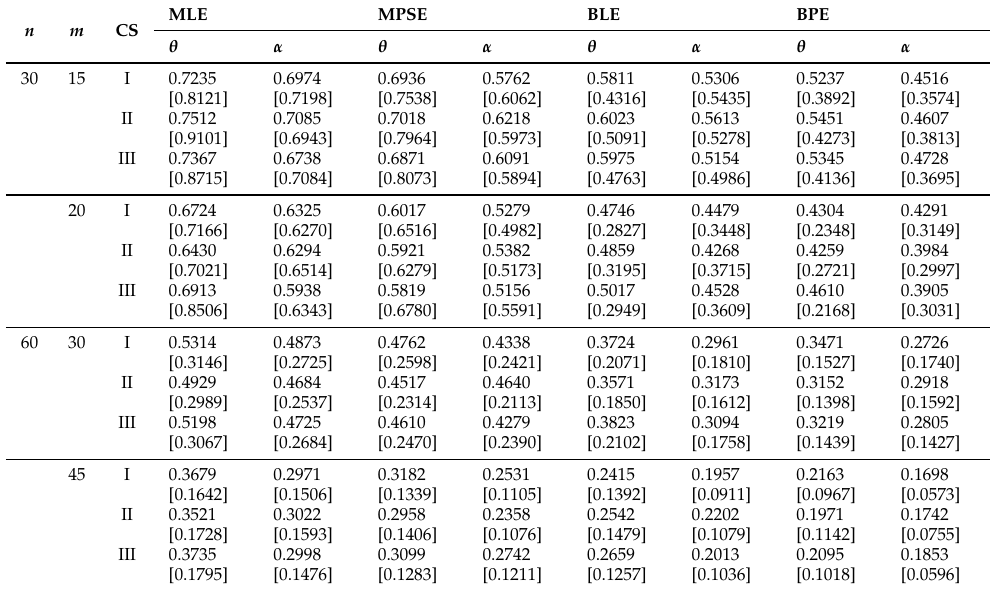
Table 1. The ABs and MSEs (within bracket) for the model parameters at ( α , θ ) = ( 1.4,1.0 ) .